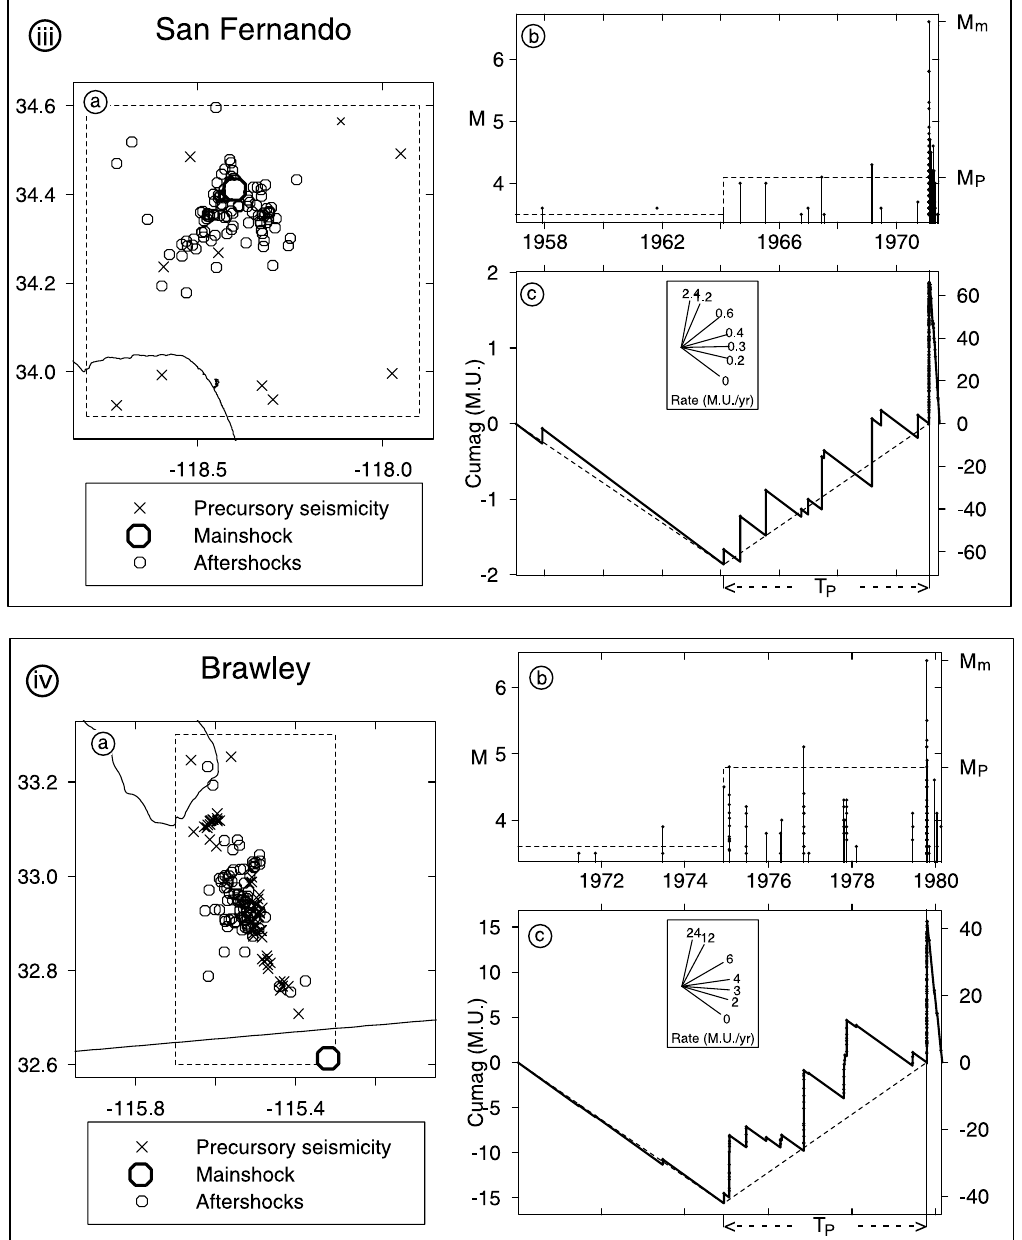
Fig. 3iii,iv. (cid:115) -phenomenon: data and interpretation for major earthquakes at (iii) San Fernando and (iv) Brawley. For explanation see caption fig.